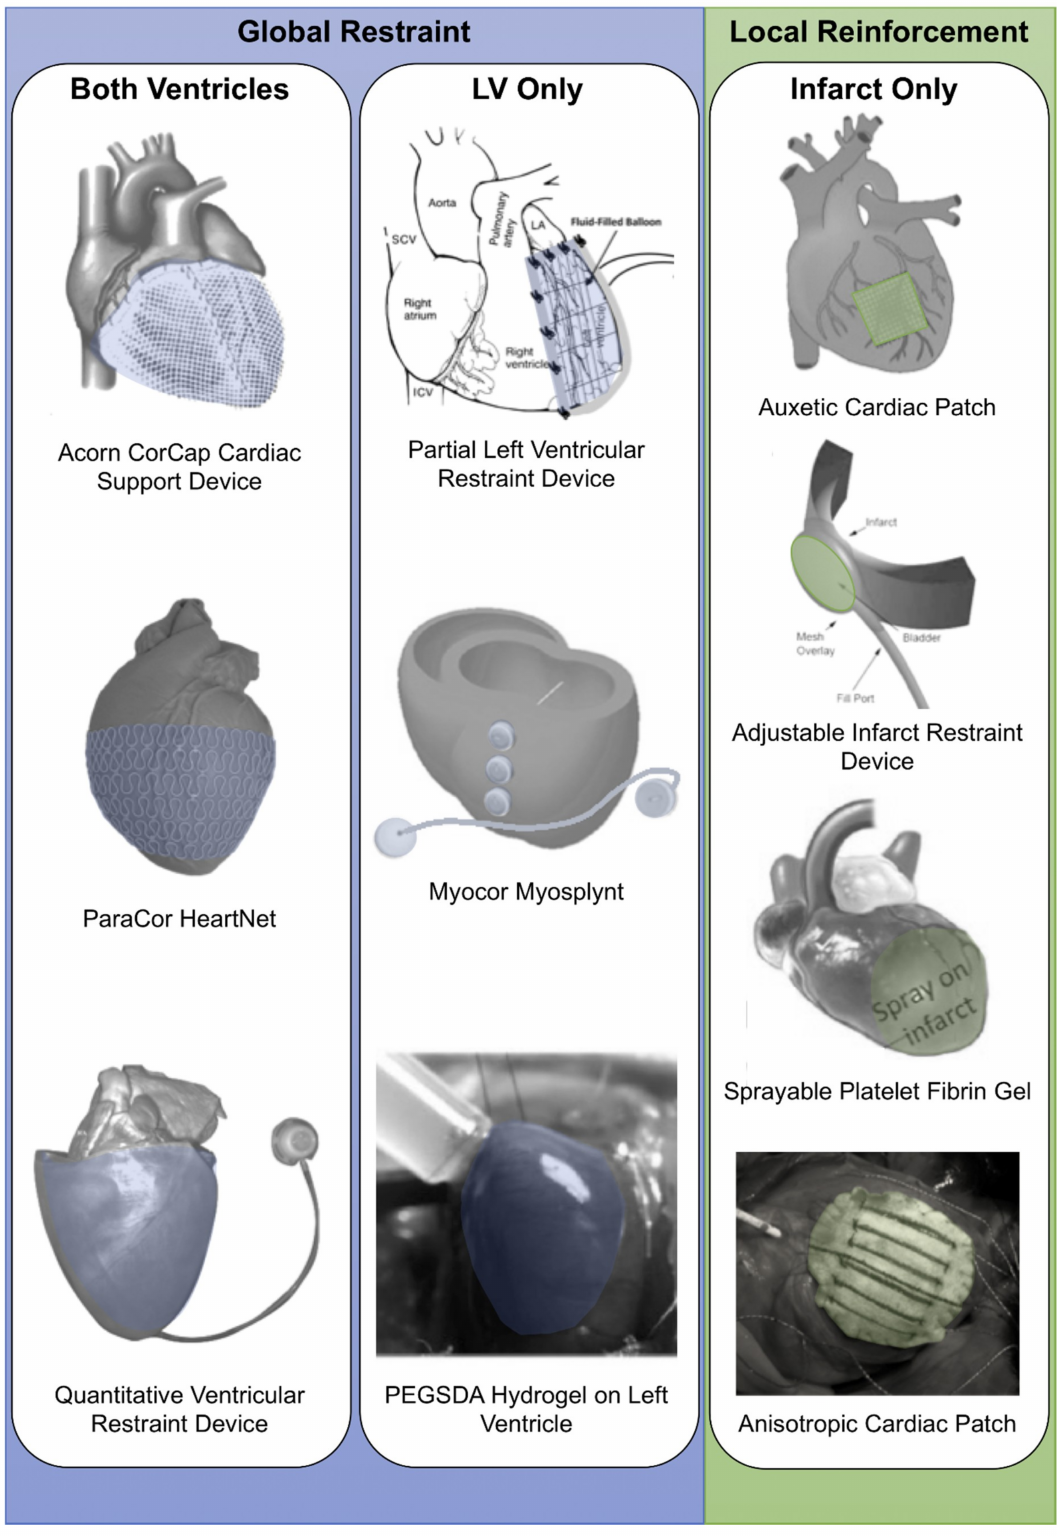
Figure 1. Visual representation of types of epicardial restraint and reinforcement devices including global restrain strategies (both ventricles and left ventricle (LV) only) and local reinforcement (infarct only). Images modified and reprinted from [8,11–19] with permission from Elsevier, Springer, Wolters Kluwer Health, Inc., and Mary Ann Liebert, Inc., respectively. PEGSDA: Poly(ethylene glycol) sebacate